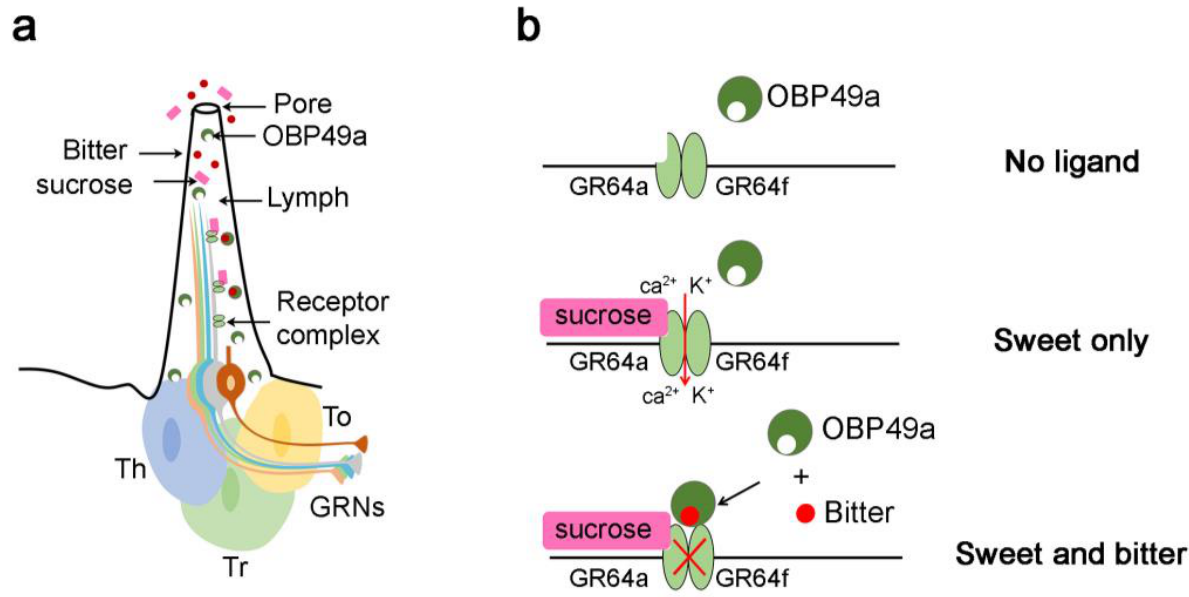
Figure 10. Hypothetical model of the suppression mechanism of sweet taste by bitter chemicals. ( a ) Schematic representation of sugar-sensing L-type sensilla. L-type sensilla end with a terminal pore and house four gustatory receptor neurons (GRNs) and one mechanosensory neuron. Three accessory cells, trichogen (Tr), thecogen (Th) and tormogen (To) cells, surround the cell body of each GRN. The GRN dendrites are bathed in the sensillum lymph containing OBP49a. ( b ) Schematic representation of the role of OBP49a. Top and middle: the sucrose receptor complex, GR64a with GR64f, is only active in the presence of sucrose. Activation of this complex leads to the entry of calcium and potassium into the neuron. Bottom: the presence of bitter compounds with sucrose inhibits the GR64a and GR64f receptor complex. More precisely, bitter compounds bind to OBP49a, and this complex inhibits the receptor even in the presence of sucrose. Adapted from [36,122].